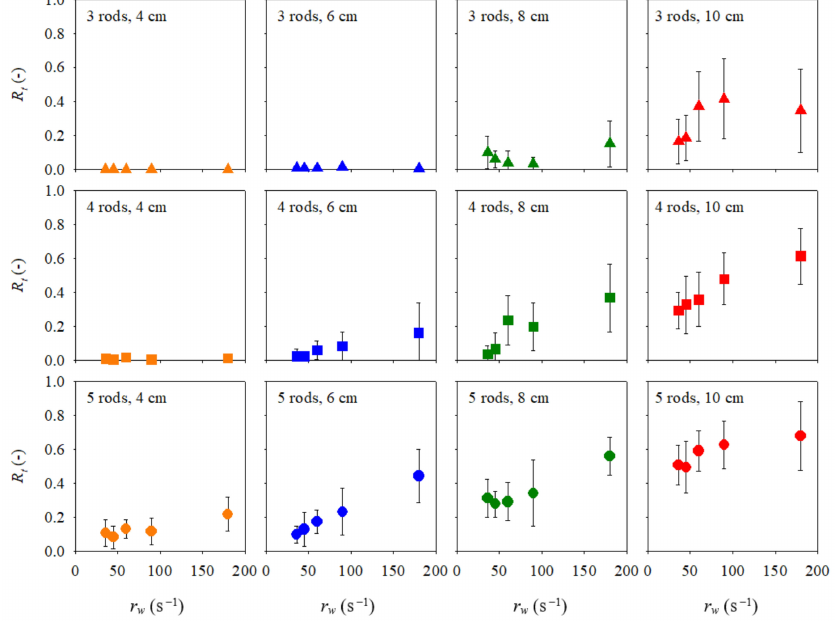
Figure 10. Experimental relationship between the LW supply rate ( r w ) and the trapping rate ( R t ) with the constant number LW supply method. The dots and bars are the means and standard deviations of the trapping rates (triangle: 3 rods, square: 4 rods, circle: 5 rods, orange: 4 cm, blue: 6 cm, green: 8 cm, red: 10 cm